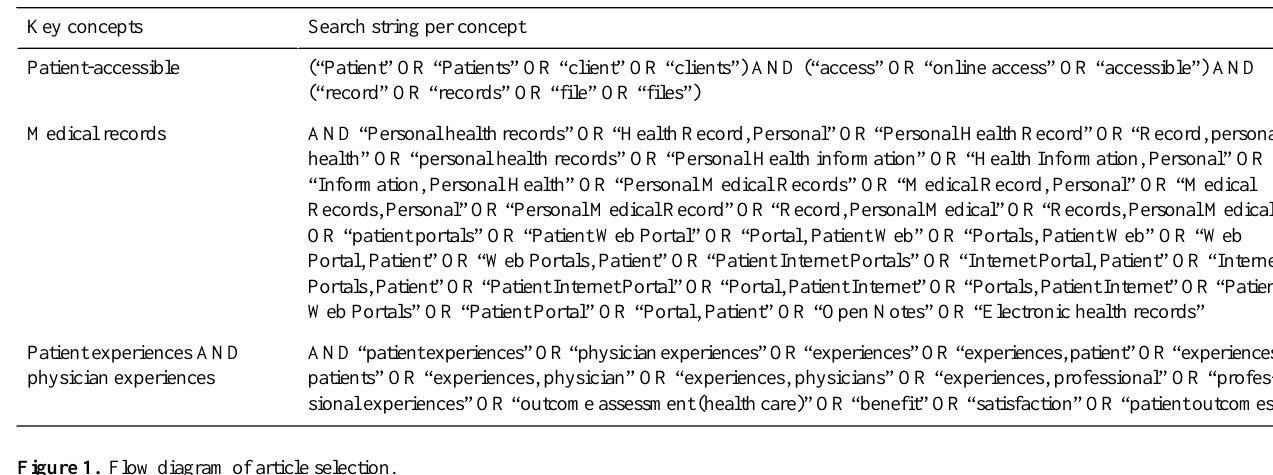
Table 1. Full search string for Scopus, split into three key concepts.